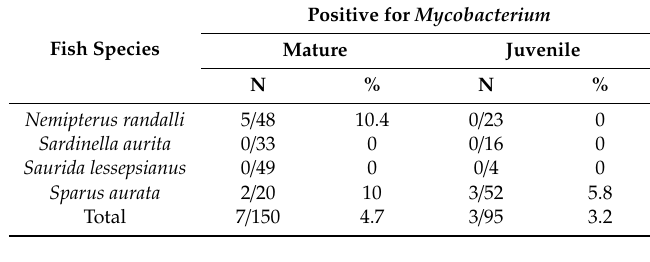
Table 10. Relative distribution and percentage of Mycobacterium in juvenile and adult wild and cultured fish.